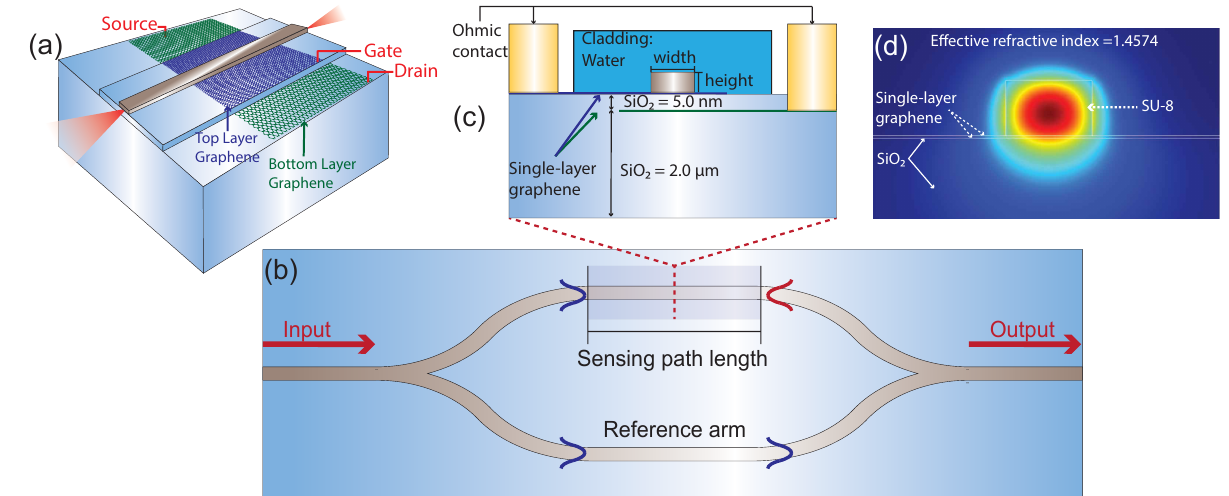
Figure 1. Design of the proposed polymeric sensor. ( a ) 3D view of a short section in the sensing area, where the interaction between the graphene-based capacitor and the polymeric waveguide, is presented. ( b ) Schematic of Mach-Zehnder interferometer biosensor. ( c ) Cross-section view of the sensing area, where the proposed device configuration is shown. ( d ) Mode distribution in SU-8 waveguide, interacting with the capacitive